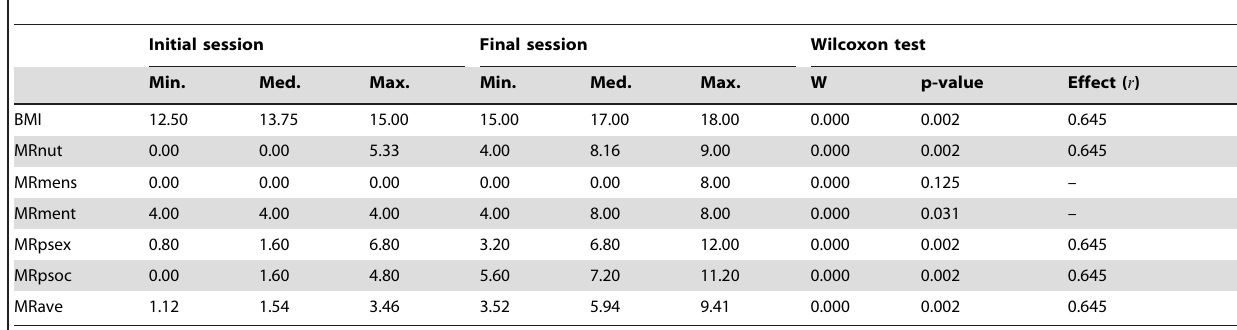
Table 2. Changes in individual clinical measures during BSFT sessions for AN patients.